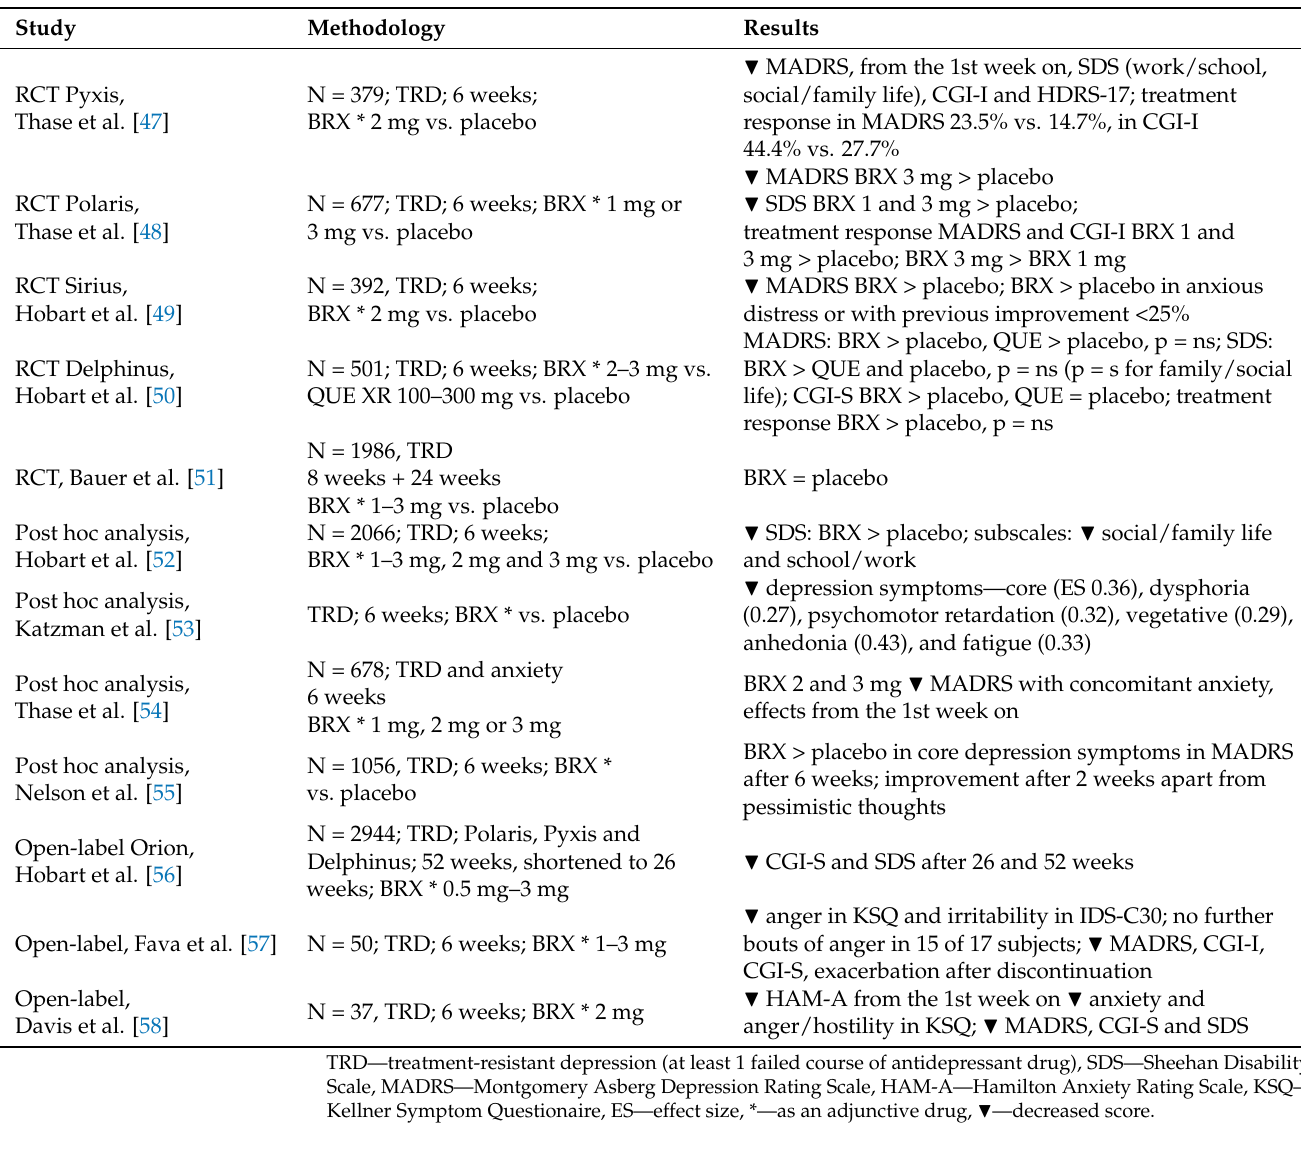
Table 4. Studies assessing effects of the brexpiprazole in treatment-resistant depression.